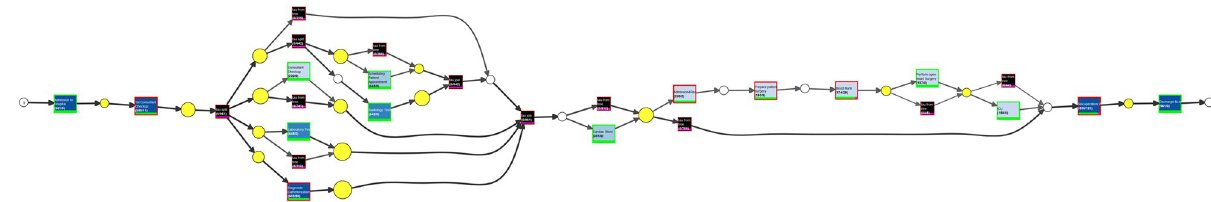
Fig 15. Result Replay of Petri net based on inductive miner with extracted log.